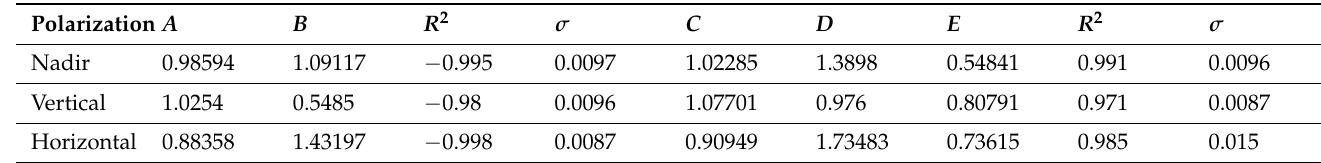
Table 1. Empirical coefficients in Formula (1).